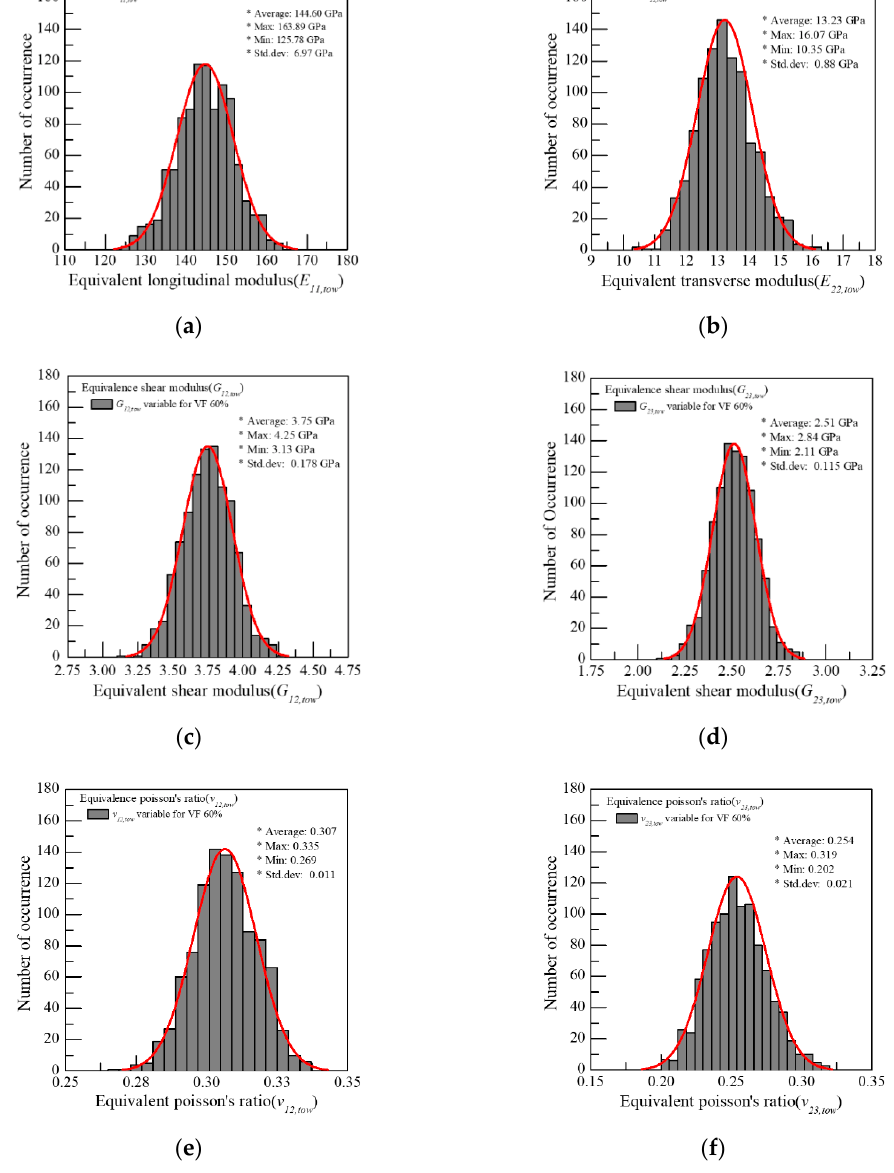
Figure 6. Result of MCS for the micro-level: ( a ) Equivalent longitudinal modulus ( E 11,tow ); ( b ) Equivalent transverse modulus ( E 22,tow ); ( c ) Equivalent shear modulus ( G 12,tow ); ( d ) Equivalent shear modulus ( G 23,tow ); ( e ) Equivalent Poisson’s ratio ( v 12,tow ); ( f ) Equivalent Poisson’s ratio ( v 23,tow ).